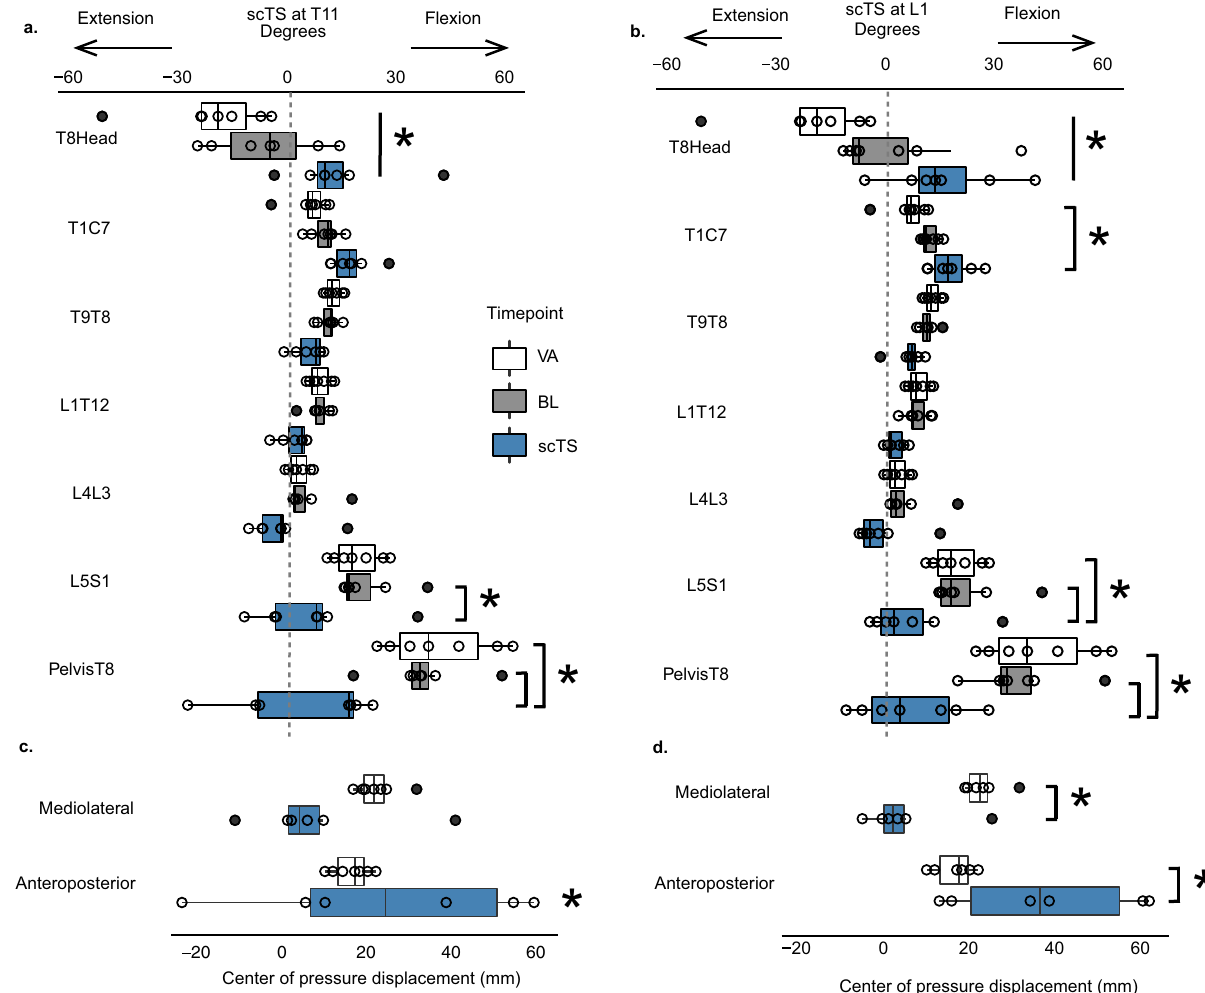
Fig. 3 Acute effects of lumbosacral transcutaneous spinal cord stimulation on segmental trunk extension in children with SCI. Box plots of angles at each measured trunk segment averaged over 10 s of the participants ’ volitional attempt (VA) to sit upright (white boxes) (average of 3 trials), prior to stimulation, baseline (BL) resting sitting (gray boxes) or during 10 s of sitting with scTS at T11 ( a ) and L1 ( b ) at the upright posture-inducing, scTS intensities optimized for each individual (blue boxes) ( n = 7 participants for each stimulation site, 1 trial at each stimulation site on the third day). Change in anteroposterior and mediolateral center of pressure displacement (COP, millimeters, mm) during scTS at T11 ( c ) and L1 ( d ) relative to baseline ( n = 6 for each stimulation site, the missing data point from one of the experiments occurred due to the loss of signal from the force plate). The centerline represents the group median, the left, and right box bounds represent 25th and 75th interquartile range (IQR), respectively. Box whiskers represent 1.5 times the IQR. The overlaying dots represent individual data points. Black dots are outlier points that lie outside of 1.5 times the IQR. The dotted line at 0° represents neutral vs. extended ( − ) or fl exed ( + ) trunk position. Mixed linear regression models were used to assess the overall differences in trunk angles and COP changes across the timepoints of baseline sitting, volitional attempt, compared to stimulation at T11 ( F 16,140 = 14.41, p < 0.0001) and L1 ( F 16,140 = 7.75, p < 0.0001), followed by Tukey ’ s post hoc t test. *denotes signi fi cance for L5S1: BL vs. T11 scTS, p = 0.03, Cohen ’ s d = 0.97; BL vs. L1 scTS, p =